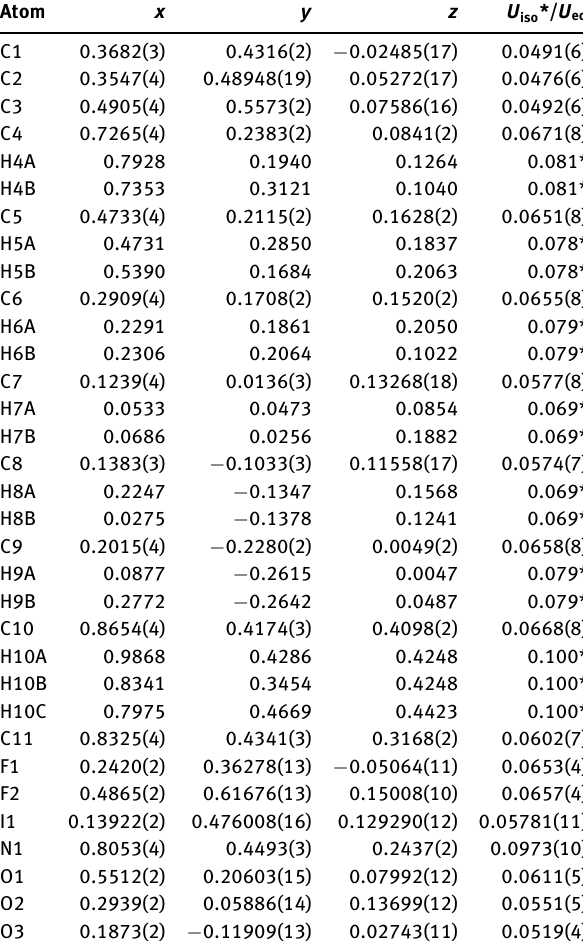
Table 2: Fractional atomic coordinates and isotropic or equivalent isotropic displacement parameters (Å 2